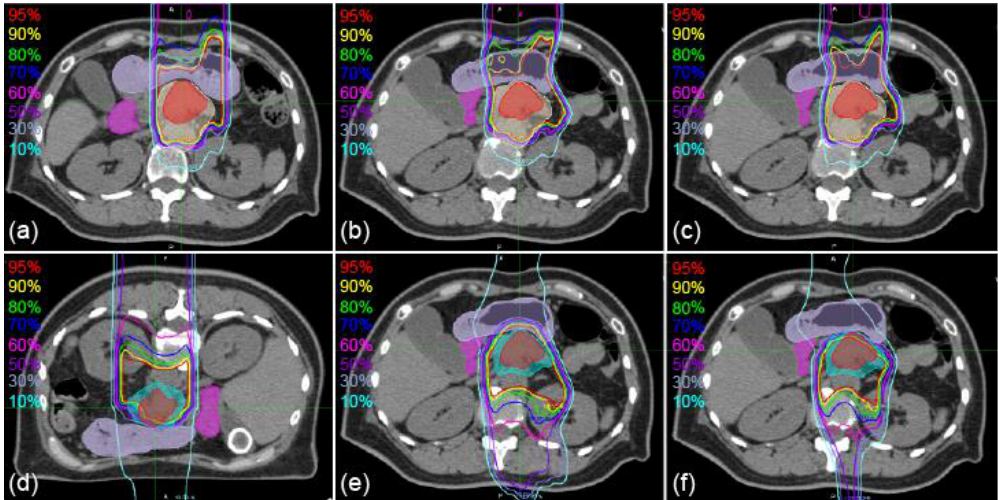
Figure 2. Sample axial images of supine and prone positions with the dose distributions of vertical beam fields. ( a ) 1st-IRCT images. ( b , c ) SP-PlanCT images. ( d ) 10th-IRCT images. ( e , f ) PR-PlanCT images. Filled red, beige, cyan, mauve, and magenta show delineations of GTV, CTV1, CTV2, stomach, and duodenum, respectively. Dose distributions are transferred from the 1st-IRCT images ( a ) to SP-PlanCT images with iDIR ( b ) and cDIR ( c ). Dose distributions are transferred from PR-PlanCT images ( d ) to SP-PlanCT images with iDIR ( e ) and cDIR ( f ).